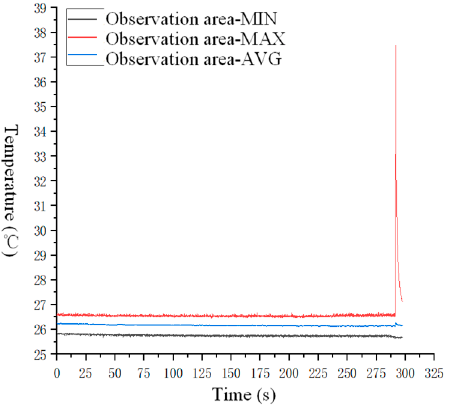
Figure 9. Temperature—time change curve of DL5-3 sample destruction process.